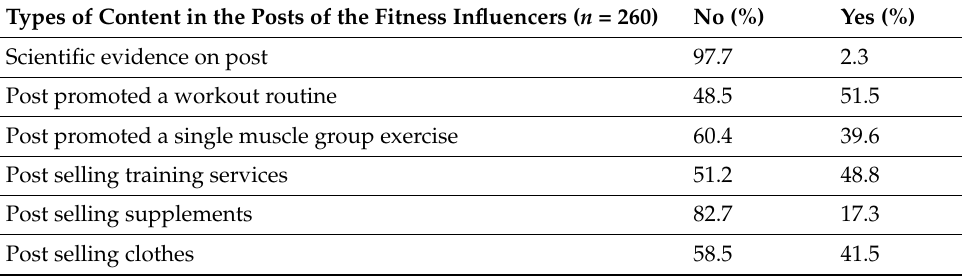
Table 2. Types of contents on the information posted by the fitness